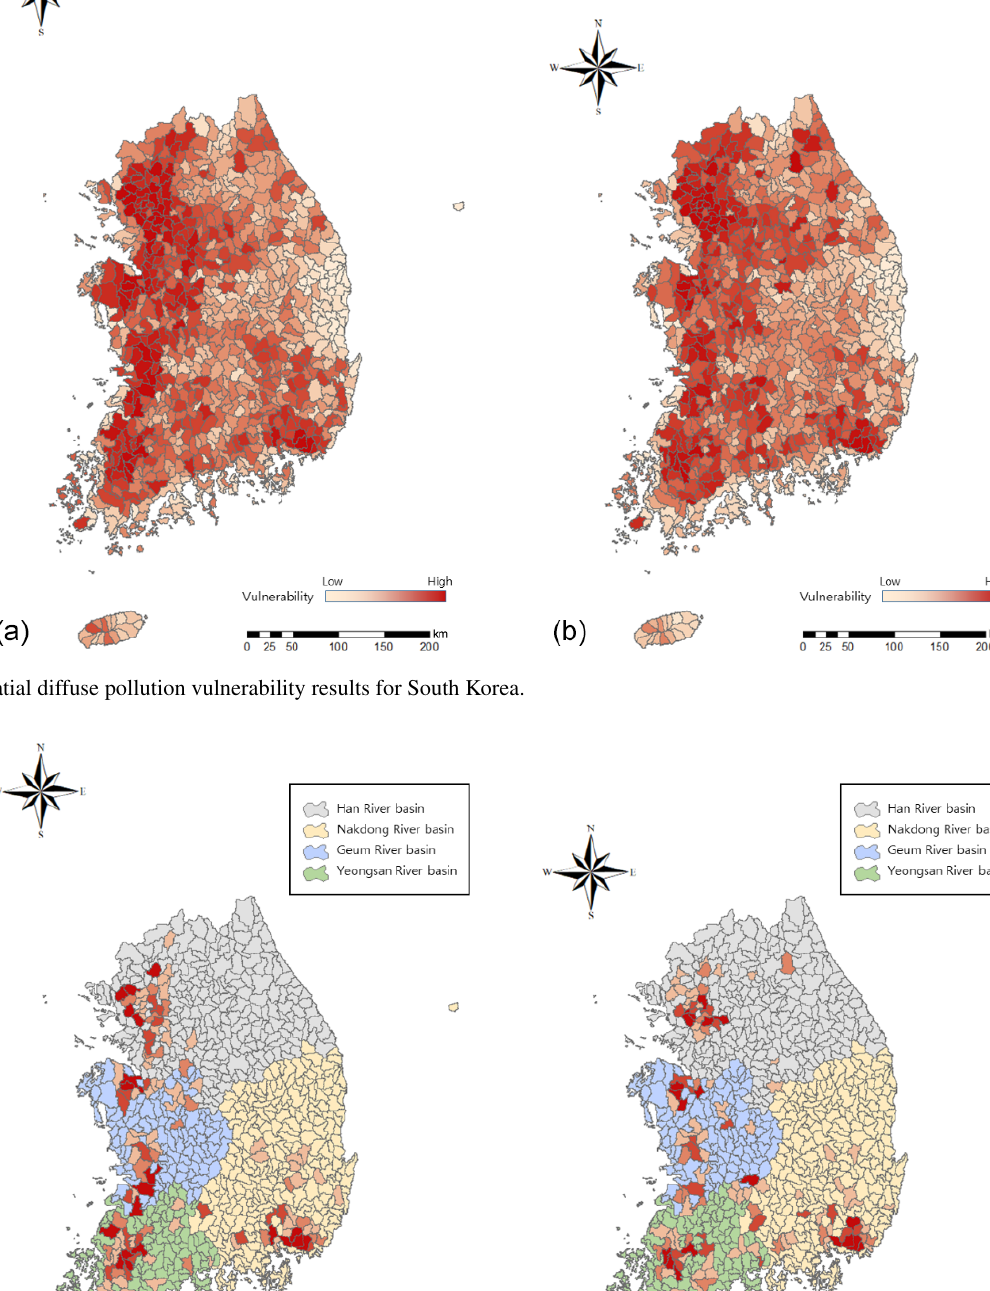
Nat. Hazards Earth Syst. Sci., 19, 2767–2779,